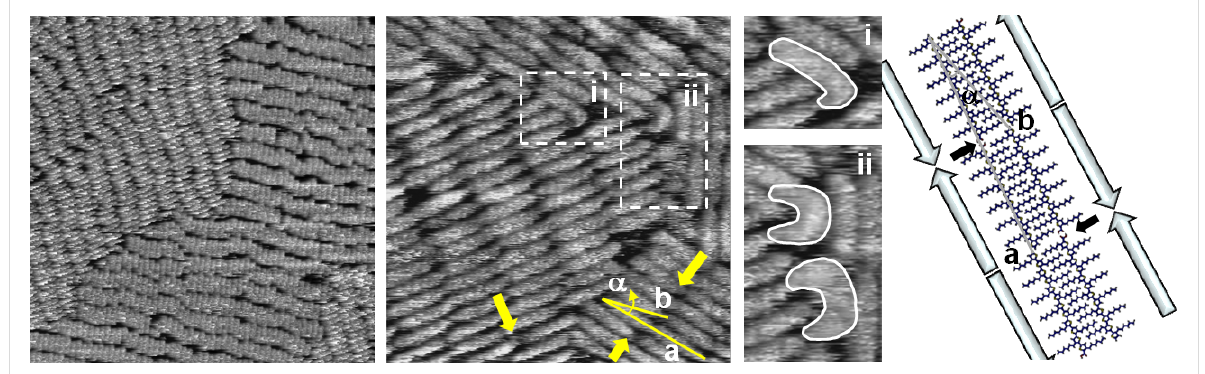
Figure 6: STM images of H12TCOOH . Left: 80 × 80 nm 2 , U = − 200 mV, I = 73 pA. Center: 20 × 20 nm 2 , U = − 750 mV, I = 68 pA. Details of the regions in the dashed rectangles are given in (i) and (ii). Right: Theoretical model. The small black arrows point out the H-bonding position. The big arrows show the orientation of the molecular dipole moments.